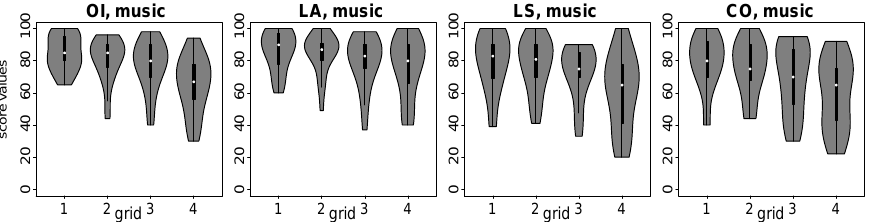
Figure 11. Ratings of quality features for the different grids and for the music signal as violin plots including box-plots; OI. . . Overall Impression with 0 = poor and 100 = very good, LA. . . Localization Ability with 0 = poor and 100 = very good, LS. . . Localization Stability with 0 = poor and 100 = very good, CO. . . Coloration with 0 = strong coloration and 100 = no